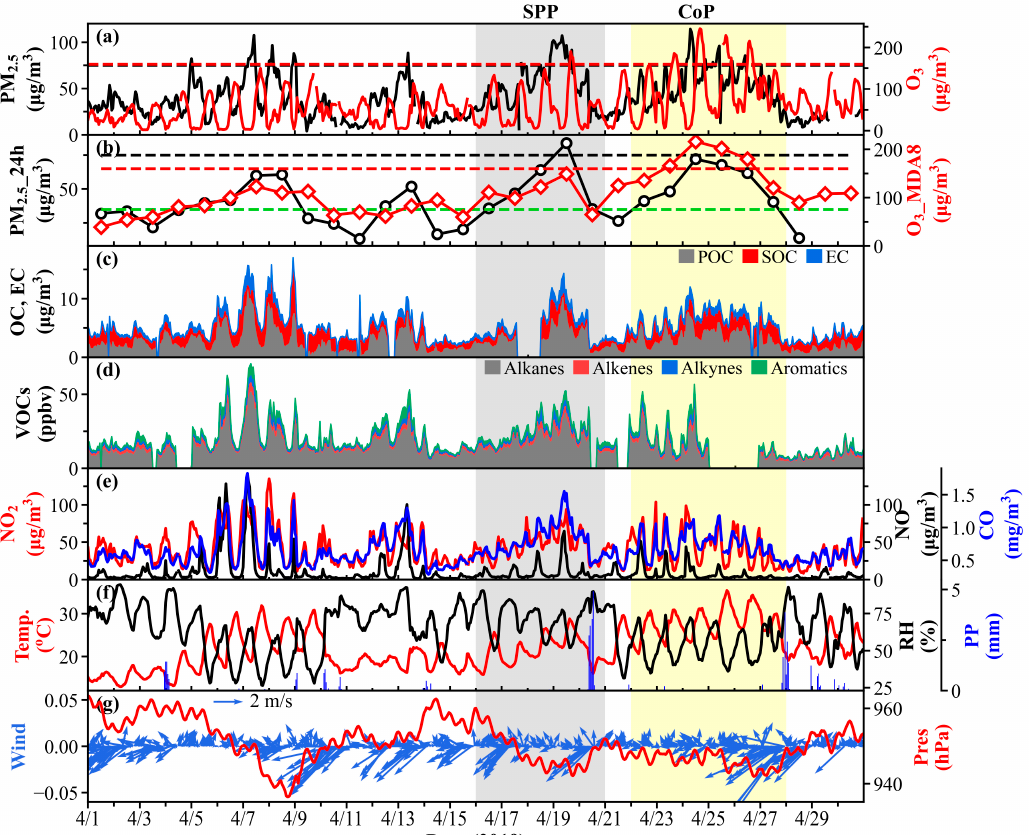
Figure 3. Time series of PM 2.5 ( a , b ) and its carbonaceous components ( c ), O 3 ( a , b ), VOCs ( d ), other gaseous pollutants ( e ), and meteorological parameters ( f , g ). The grey and yellow areas represent the SPP and CoP episodes, respectively.